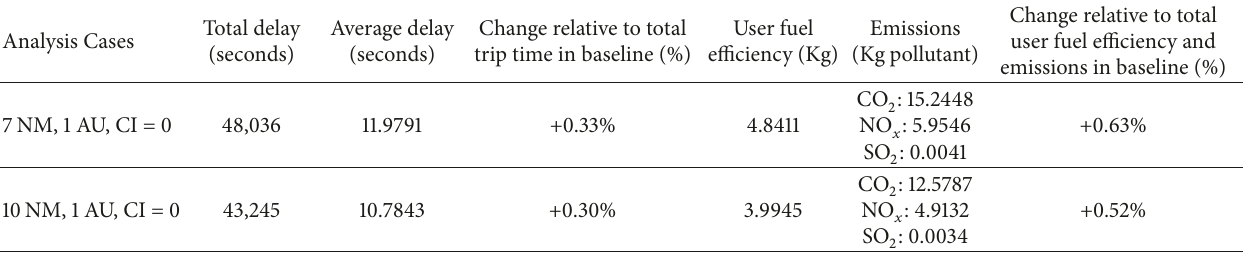
Table 3: Delay, user fuel efficiency, and emissions for the analysis cases of 7NM/1-AU/CI = 0 and 10NM/1-AU/CI = 0.